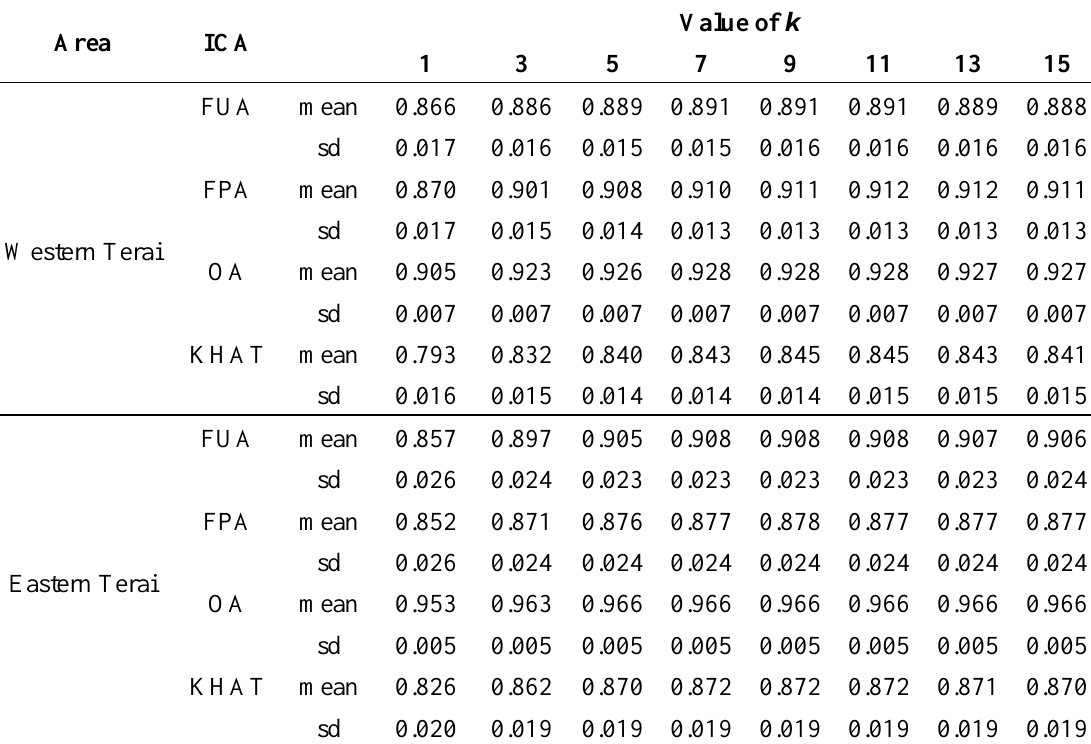
Table 3. Statistics (mean and standard deviation (sd)) by the four indicators of classification accuracy (ICA): (1) the user’s accuracy of forest class (FUA), (2) the producer’s accuracy of forest class (FPA), (3) overall accuracy (OA) and (4) Kappa statistic (KHAT) based on the test samples for each value of k